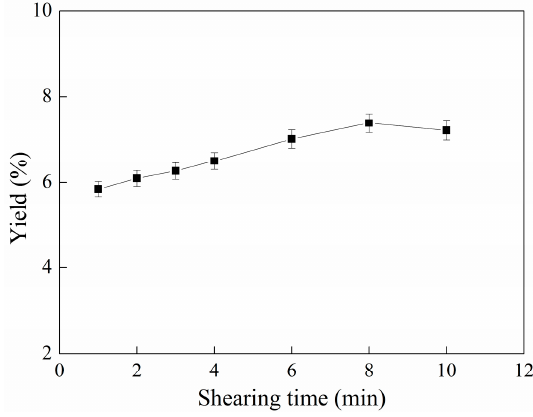
Figure 2. Relationship between shearing time and yield of C-PC. Error bars indicate standard deviations of the means ( n = 3).